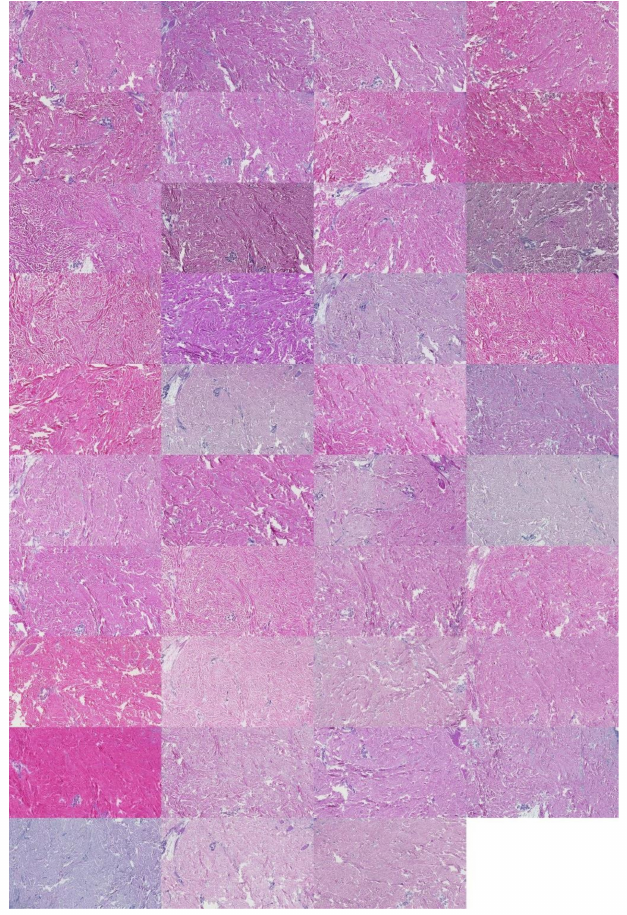
Figure A8. Skin examples visualized by descending silhouette score within the second cluster found (C2). Silhouette values descend in the left direction from the left-most example in the first